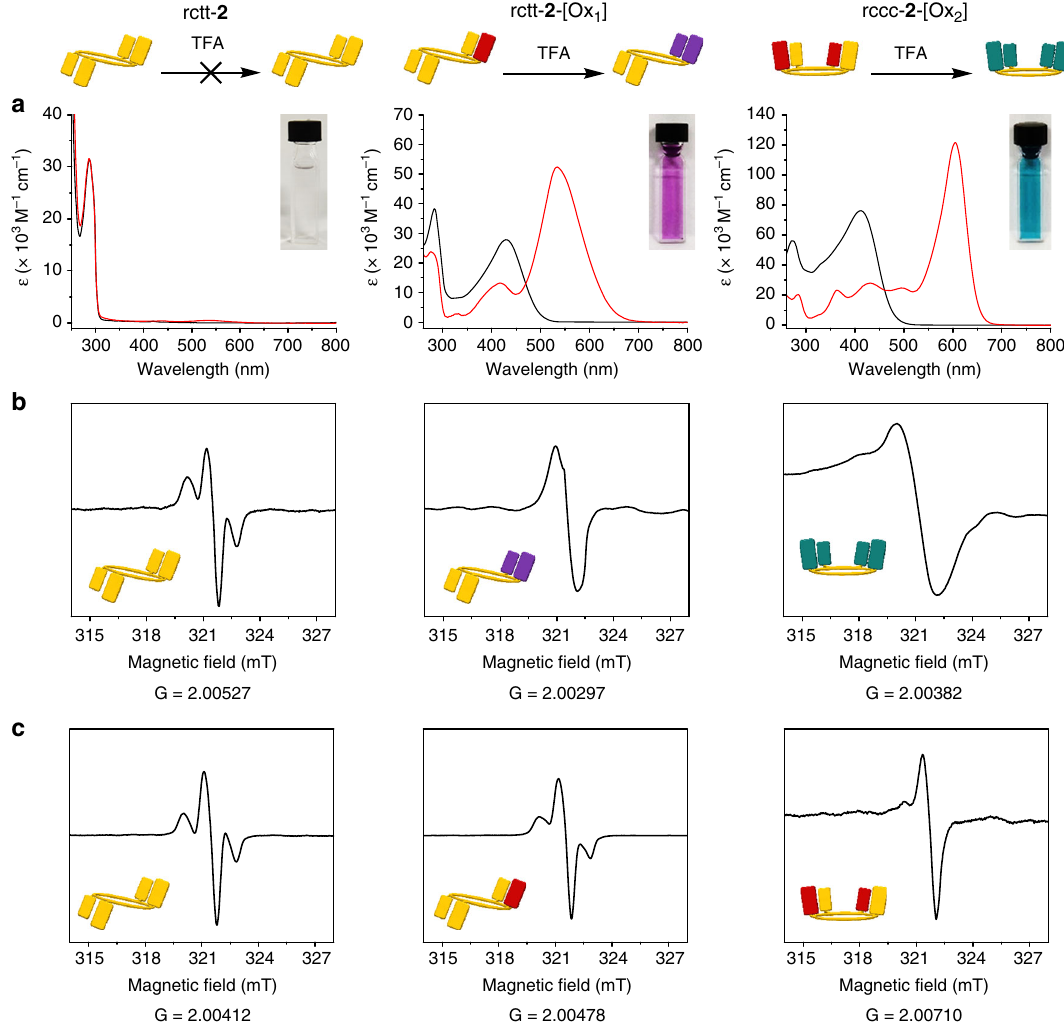
Fig. 6 Electronic absorption and X-band electron spin resonance (ESR) spectra of series 2 compounds. a Electronic absorption spectra of rctt- 2 (left), rctt- 2 -[Ox 1 ] (middle) and rccc- 2 -[Ox 2 ] (right) in neutral (black lines, CHCl 3 , [rctt- 2 ], [rctt- 2 -[Ox 1 ]] and [rccc- 2 -[Ox 2 ]] = 2.47×10 − 5 mol) and acidi fi ed (red lines, [rctt- 2 ] = 1.02×10 − 3 moldm − 3 in TFA/CHCl 3 (89mM), [rctt- 2 -[Ox 1 ]] and [rccc- 2 -[Ox 2 ]] = 4.94×10 − 5 moldm − 3 in TFA) solutions. Insets show the appearance of the acidi fi ed solutions (see also Supplementary Figure 12). b ESR spectra of rctt- 2 (left), rctt- 2 -[Ox 1 ] (middle) and rccc- 2 -[Ox 2 ] (right) in p -toluenesulfonic acid in the solid state (acidi fi ed solutions of the compounds are ESR silent). c ESR spectra rctt- 2 (left), rctt- 2 -[Ox 1 ] (middle) and rccc- 2 -[Ox 2 ] logic gate operations, molecular switches, chemical memory ele- ments or chemosensors.